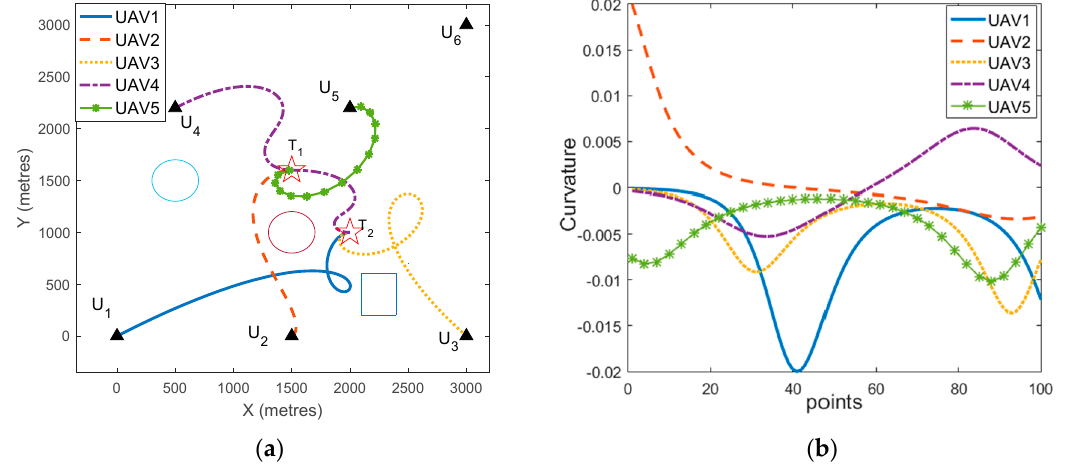
Figure 2. ( a ) The mission planning results for two targets; ( b ) curvature of each UAV’s path.